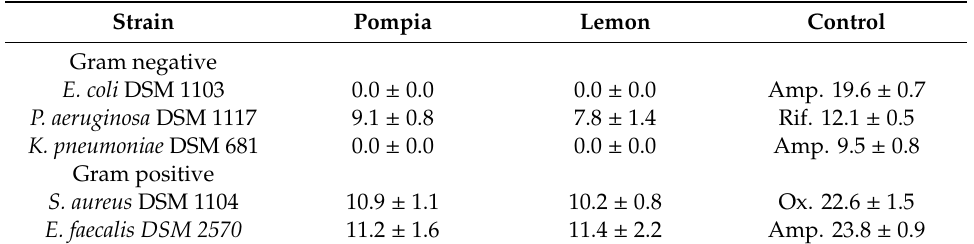
Table 3. Antimicrobial profile for Pompia and lemon juices (4 mg mL − 1 ) with a set of Gram-positive and Gram-negative bacteria. Strain Pompia Lemon